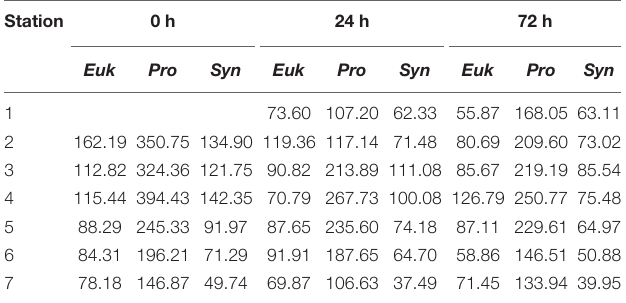
TABLE 2 | Integrated biomass (mg C · m − 2 ) between surface and 150 m depth of Eukaryotes (Euk), Prochlorococcus sp. (Pro) and Synechococcus sp. (Syn) for the three sampling days (0, 24, and 48 h) and for every